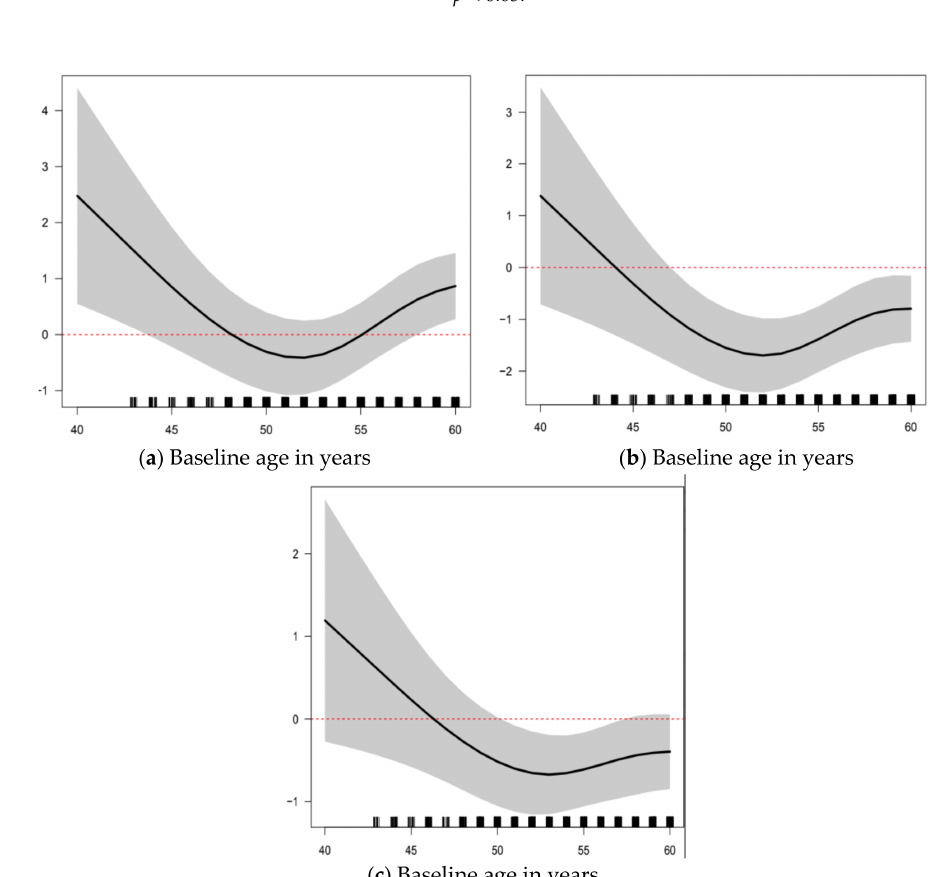
Figure 2. Two-year Percentage Change in areal Bone Mineral Density in Relationship to Baseline Age; Percent change in BMD (95% CI): ( a ) Lumbar Spine (L1-4); ( b ) Femoral Neck; and ( c ) Total Hip in Women ages 43–63 in the Canadian Multicentre Osteoporosis Study (CaM os ) (n =